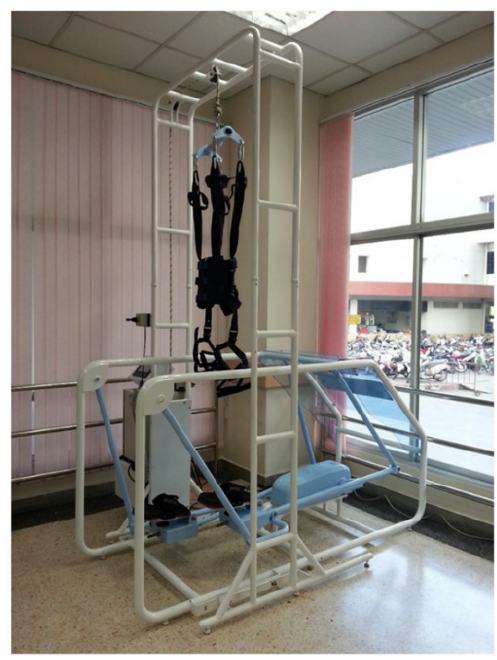
Figure 2. PT rehabilitation program with I-Walk